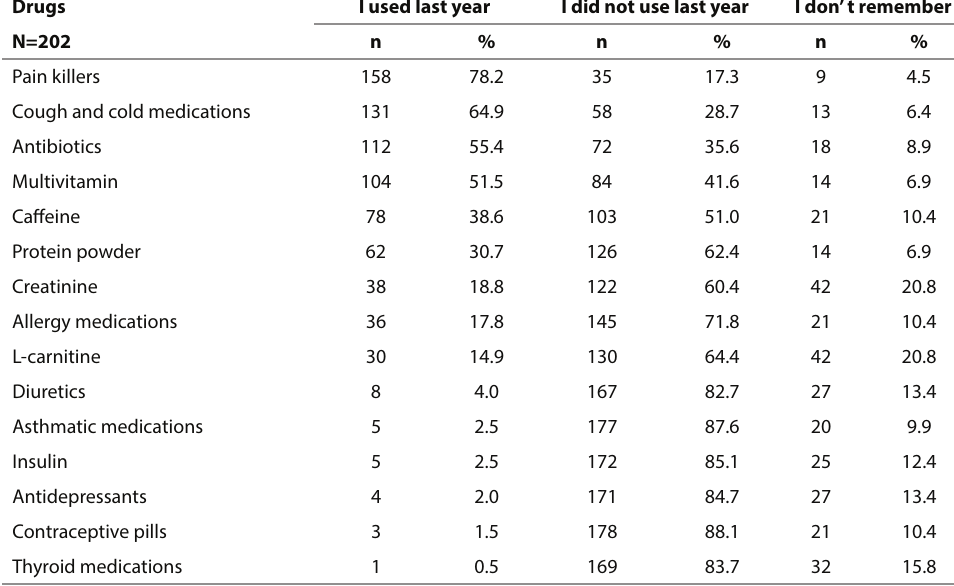
TABLE 2. Medications or supplements used by the athletes in the previous 12 months Drugs I used last year N=202 Pain killers